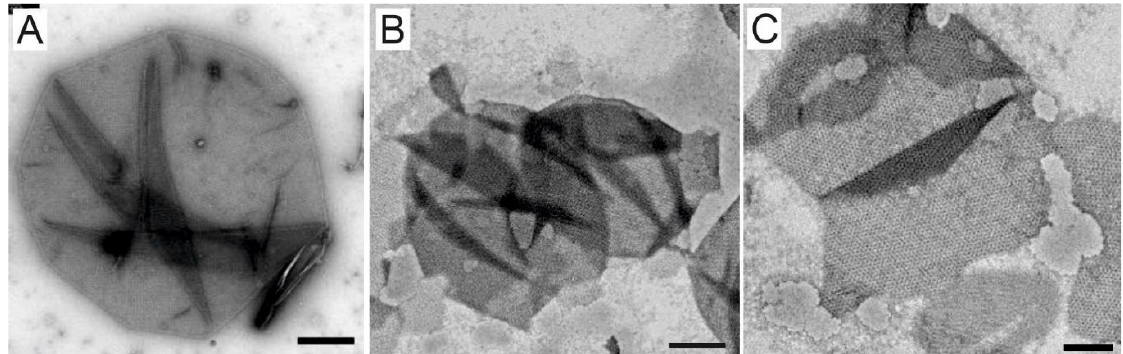
Figure 1. ( A ) Saccharolobus solfataricus P2 (SSO) ghost prepared using the extraction with DNase I (DEG). ( B ) and ( C ) SSO ghosts prepared using the extraction method with sonication (SEG). Scale Bars: A = 100 nm; B = 500 nm; C = 250 nm.